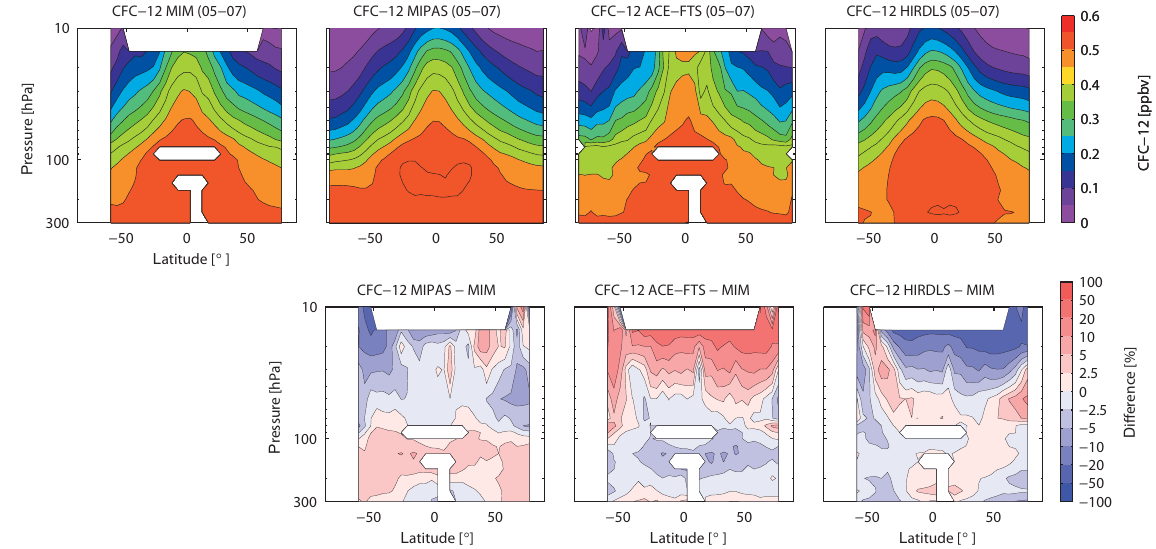
Figure 5. Altitude–latitude cross sections of annual zonal mean CFC-12 for the MIM, MIPAS, ACE-FTS and HIRDLS (upper panels) and relative differences between the individual instruments and the MIM (lower panels) are shown for